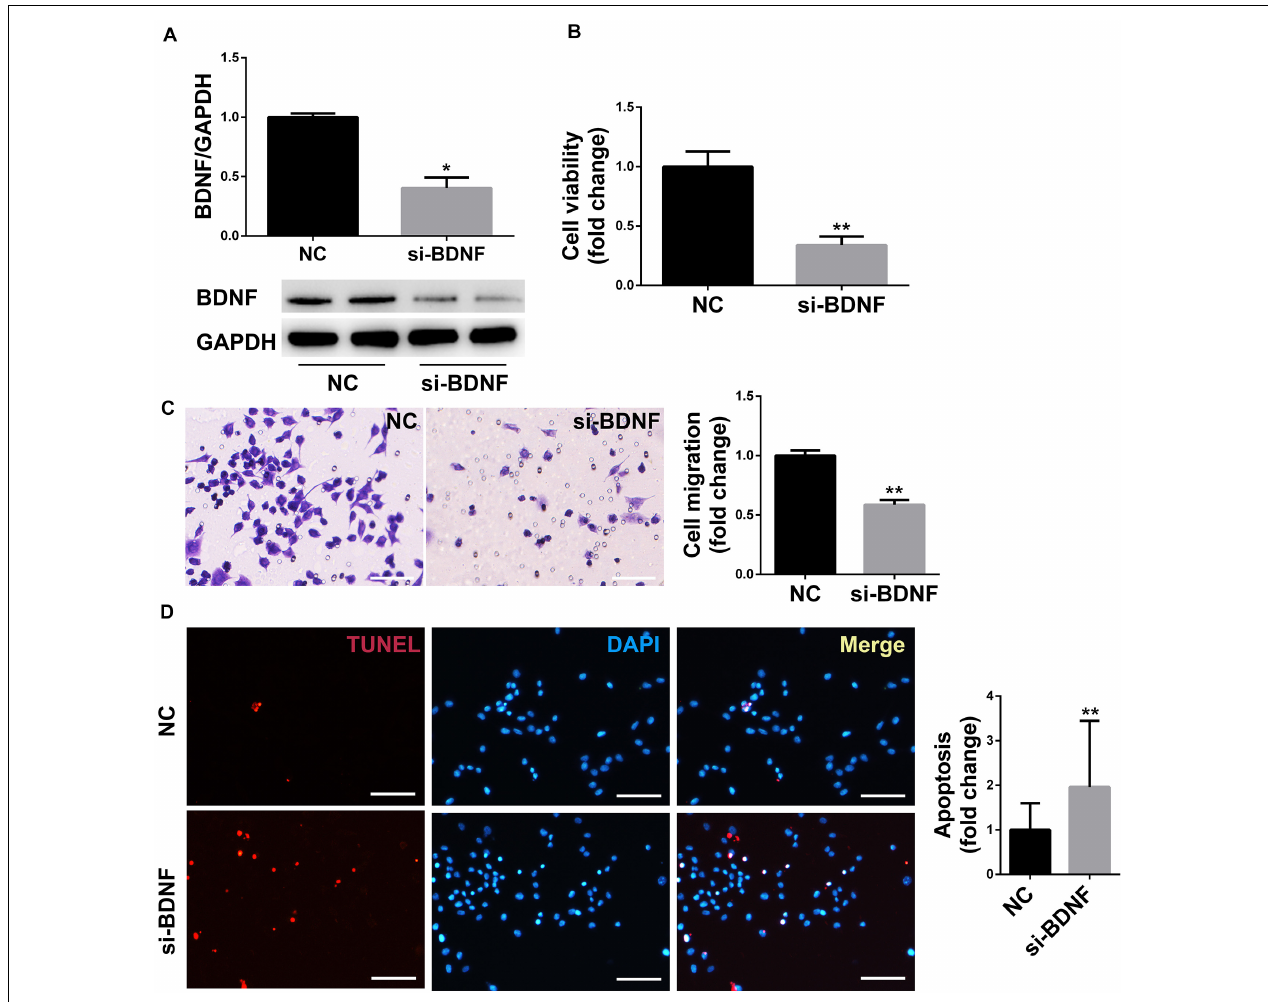
FIGURE 3 | BDNF silencing inhibited the proliferation and migration of SCs and promoted cell apoptosis. (A) Western blot was used to detect the protein expression of BDNF in RSC96. * P < 0.05 versus the NC group. (B) The cell viability was examined by CCK-8 assay. ** P < 0.01 versus the NC group. (C) The cell migration was detected by Transwell migration assay. Scale bar = 50 µ m. ** P < 0.01 versus the NC group. (D) TUNEL staining was used to detect cell apoptosis. Scale bar = 50 µ m. ** P < 0.01 versus the NC